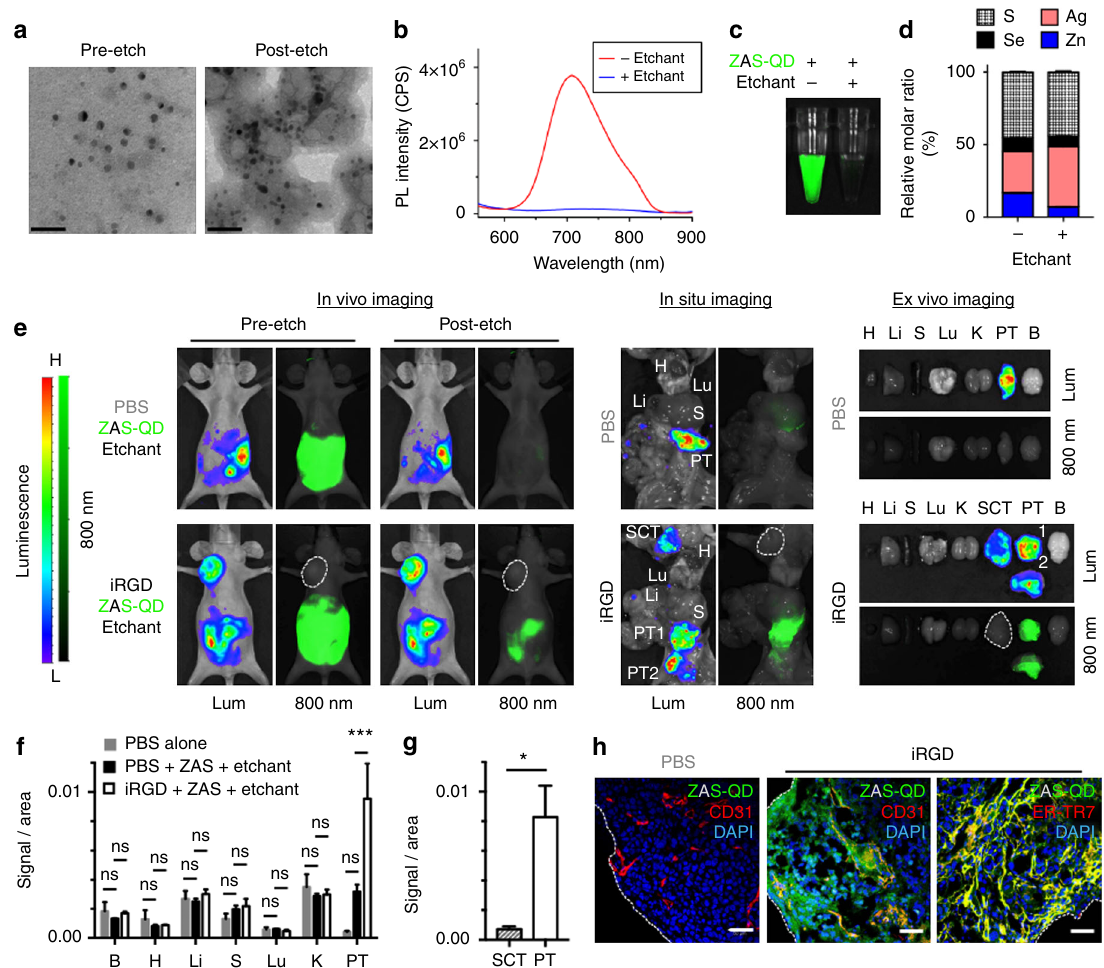
Fig. 7 Peritoneal tumor imaging with Hg-free etchable ZAS-QDs. a – c ZAS-QDs characterized by TEM a , PL spectra (excitation: 460 nm) b and NIR imaging with a Li-Cor Pearl imager (green, ZAS-QDs) c before and after Ag-TS treatment. Scale bars , 50 nm. d EDS analysis of ZAS-QDs before and after Ag-TS treatment showed relatively constant S and Se and increased Ag after etching. See Supplemental Table 1 for complete data set. n = 3 per group. e – h Mice bearing peritoneal tumors (PTs) created with MKN45P-luc luciferase-positive human gastric cancer cells received intraperitoneal co-injection of iRGD or PBS with ZAS-QDs followed by Ag-TS. n = 3 per group. In e , live in vivo and post-necropsy in situ images of the tumor mice, and ex vivo images of resected tissues are shown. Lum, luminescence; 800 nm, NIR. The white dotted line marks a subcutaneous tumor (SCT).NIR signal per unit area in collected tissues f and in SCT vs. PT in the iRGD group g . B, brain; H, heart; Li, liver; S, spleen; Lu, lung; K, kidney. Statistics, two-way analysis of variance f or Student ’ s t -test g ; error bars , SEM; ns, not signi fi cant; * P < 0.05; *** P < 0.001. Confocal micrographs of PTs h . Blue, DAPI; red, CD31 or ER-TR7; green, ZAS-QDs; scale bars , 50 μ m; white dotted lines in h , PT